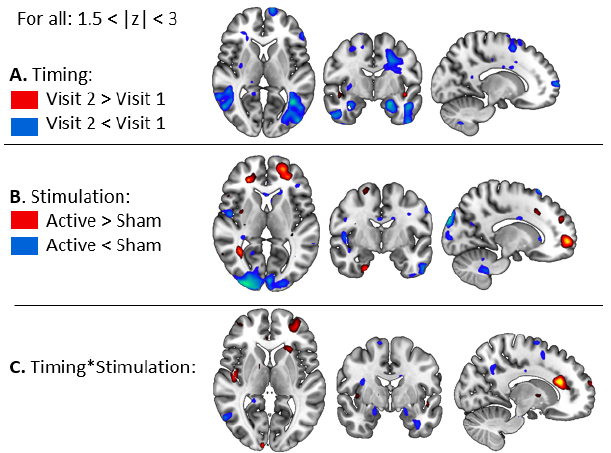
Figure 3. Results from the 2*2 ANOVA on BOLD signal. ( A ) Main effect of Timing (Pre versus Post rTMS). ( B ) Main effect of Stimulation (Active versus Sham rTMS), and ( C ) Interaction between Timing and